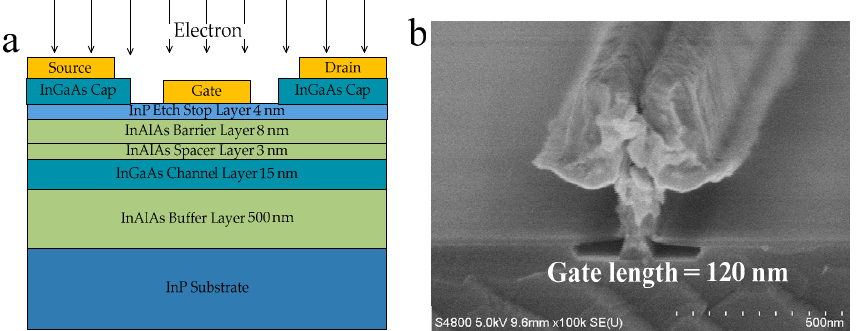
Figure 1. ( a ) Epitaxial layer structure of the InP-based high electron mobility transistor (HEMT), ( b ) scanning electron microscope (SEM) photographs of a vertical profile of the T-gate of InP-based HEMTs.